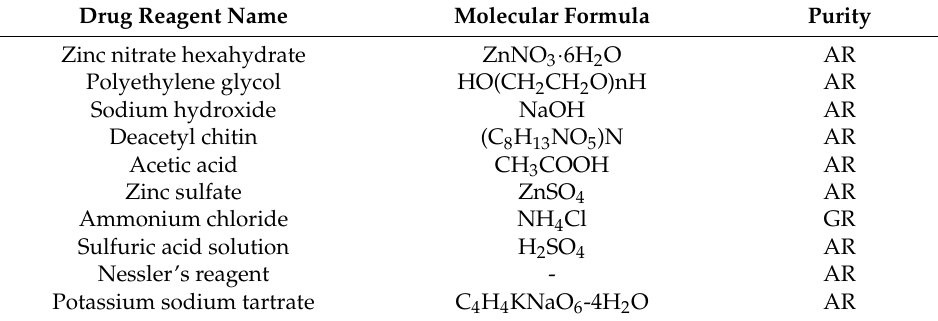
Table 1. The detailed information on the experimental reagents.